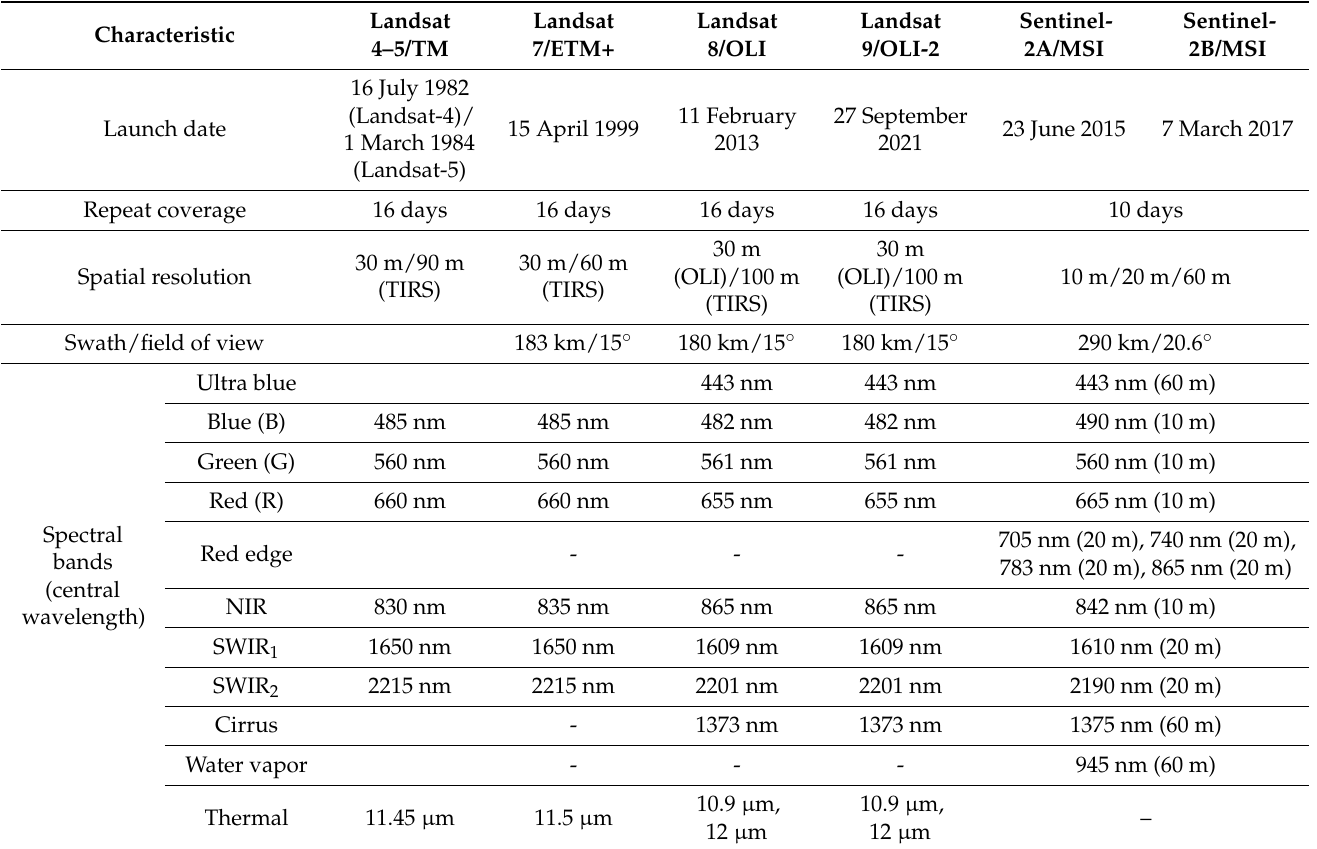
Table 1. Landsat and Sentinel-2 sensor specifications (adapted from